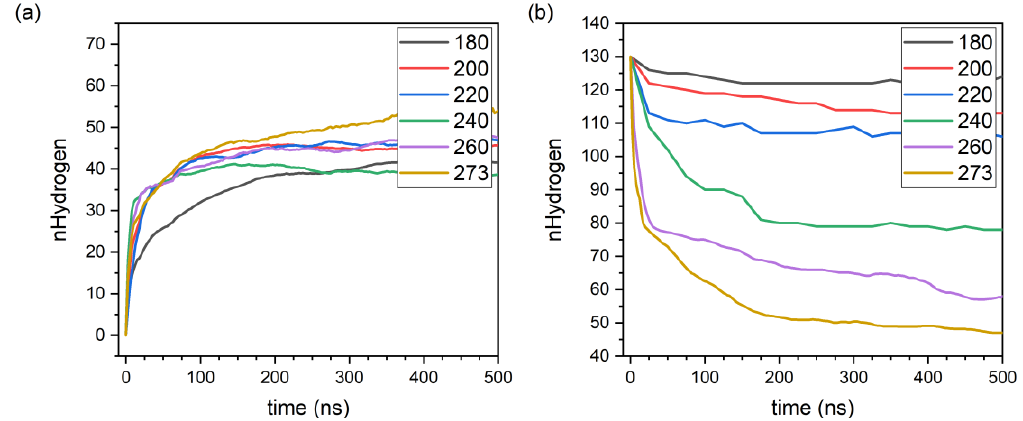
Figure 3. Hydrogen uptake ( a ) and release ( b ) in non-equilibrium simulations at various temperature. The density map of molecules (water, propane and hydrogen) along the X-axis at different time